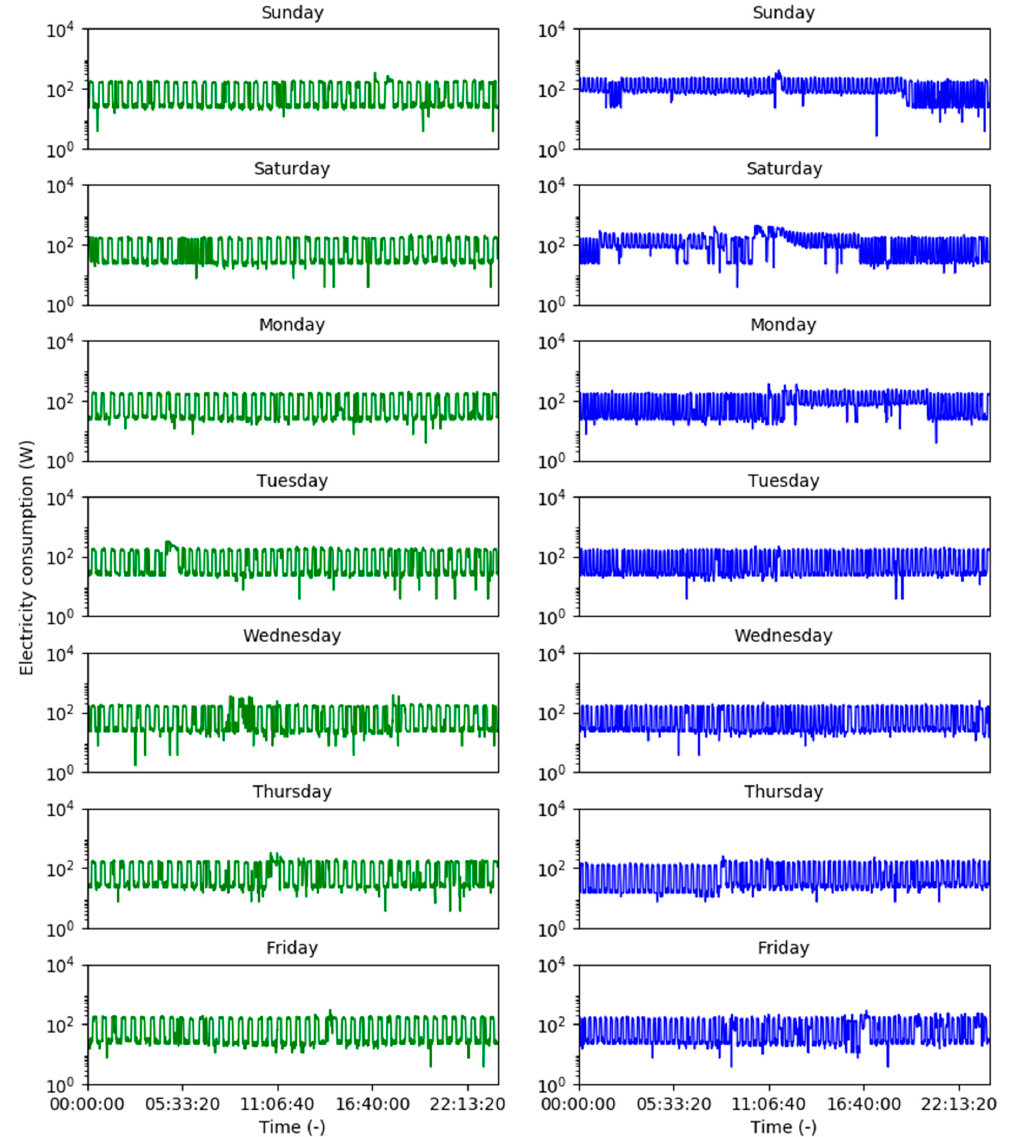
Daily representative electricity demand profile for ‘Home 4’ without A / C ((Green) 3–9 November 2018, (Blue) 22–28 December 2018).